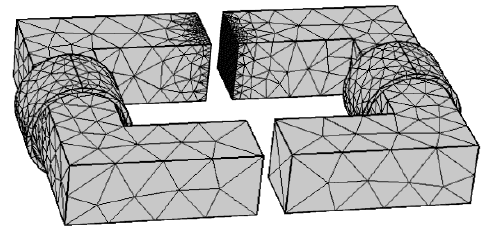
Figure 2. The mesh used in the FEM